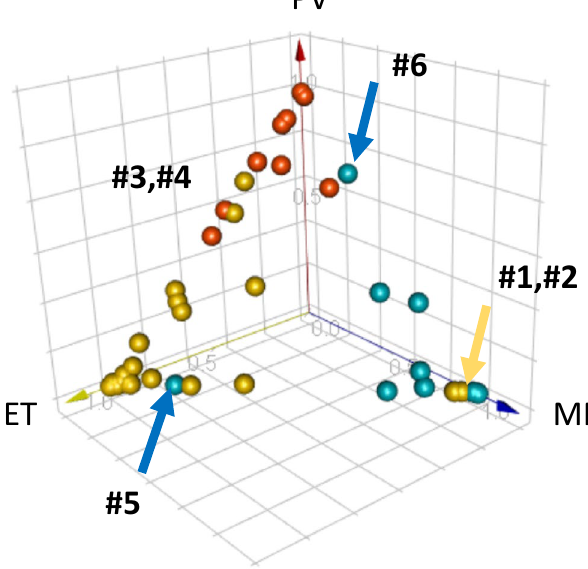
Figure 4. Three-dimensional plot of the predicted likelihood for all cases. Case #1 and Case #2: Definitive diagnosis ET, automated diagnosis MF. Case #3 and Case #4: Definitive diagnosis ET, automated diagnosis PV.